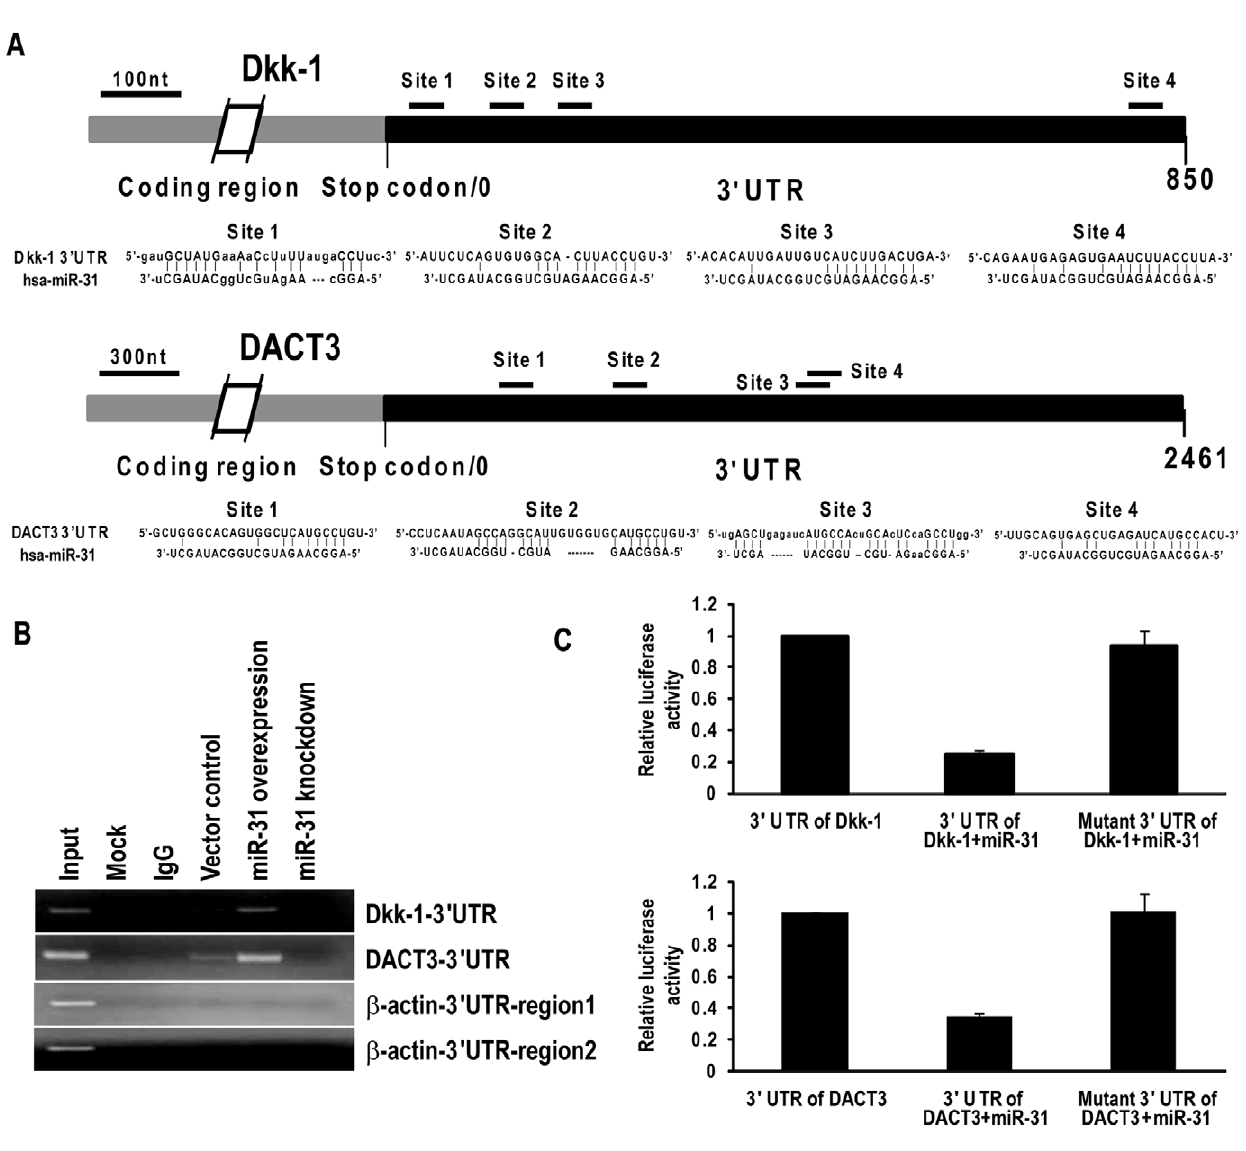
Figure 3. WNT signaling pathway antagonists are direct target candidates of miR-31. A) Putative target sites of miR-31 within Dkk-1 3 9 UTR (top) and DACT3 3 9 UTR (bottom). B) miRNA-targeted transcripts in RISC were precipitated with AGO family antibodies after UV induced cross- linking of RNAs to their binding proteins, followed by RT-PCR amplification. Over-expression of miR-31 significantly increased precipitation of Dkk-1 and DACT3 target transcripts in SAEC cells. b -actin served as the negative control since no sequences in the 3 9 UTR that can be targeted by miR-31. C) Luciferase assays demonstrating reduction in luciferase activity in SAEC transfected with pMiR-Report vectors with or without insertion 3 9 UTR or mutated 3 9 UTR of WNT signaling antagonists. as well as Calu-6 cells following CSC treatment (Figure 5E; right panel). Collectively, these data strongly suggest that C/EBP- b contributes to up-regulation of LOC554202 and miR-31 by CSC.